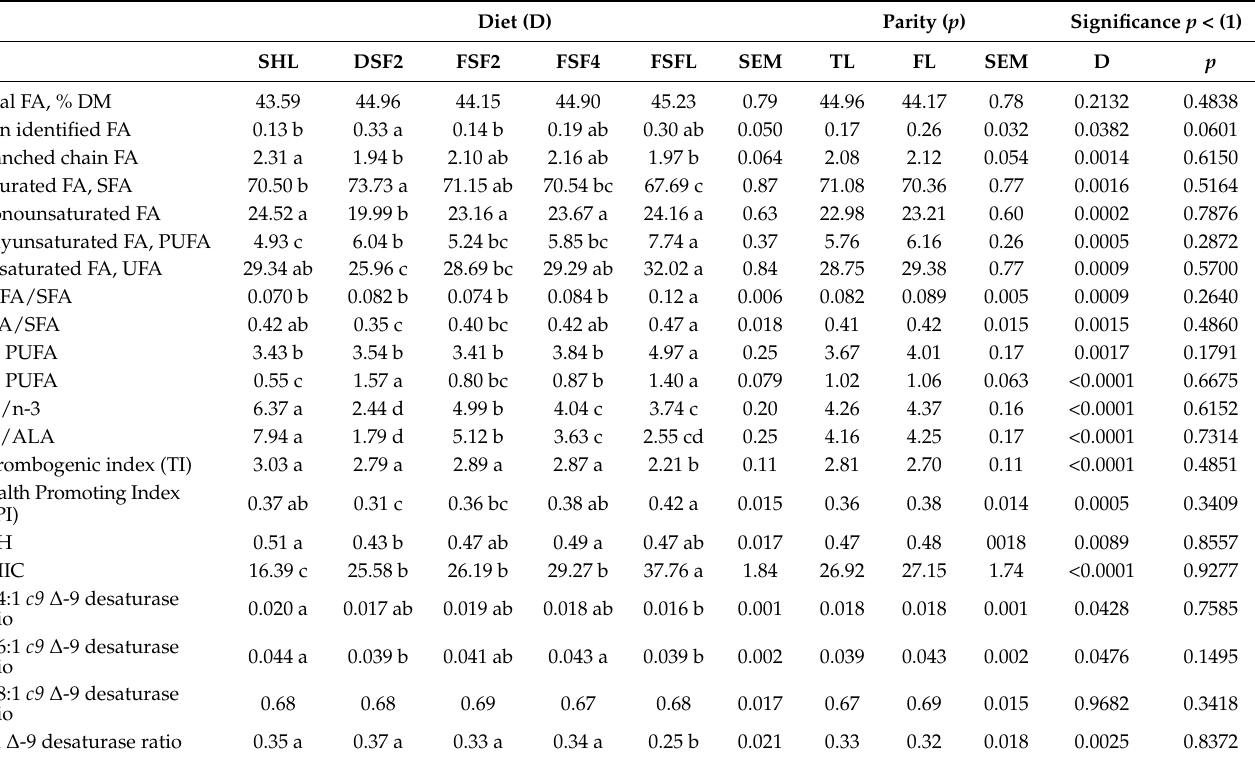
Table 5. The effect of diet and parity on fatty acid (FA) profile (g/100 g FA) and health indexes of cheese